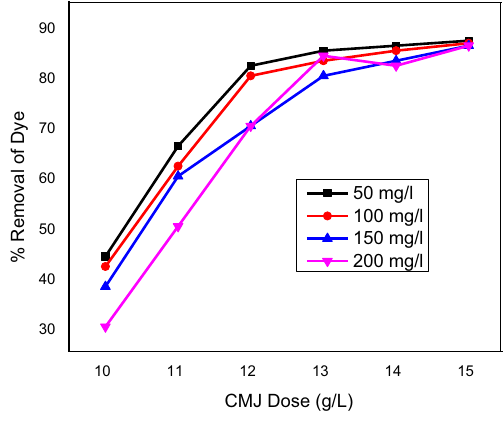
Fig. 5 Percentage removal of dye against SCTJF